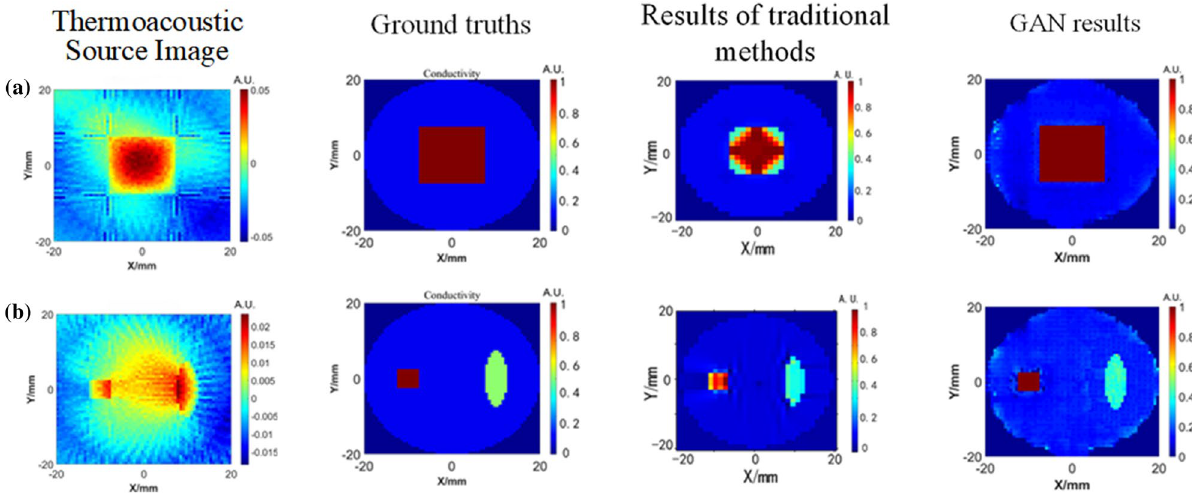
Figure 8. Thermoacoustic source images and conductivity reconstruction results of the models ( a ) simple model ( b ) complex